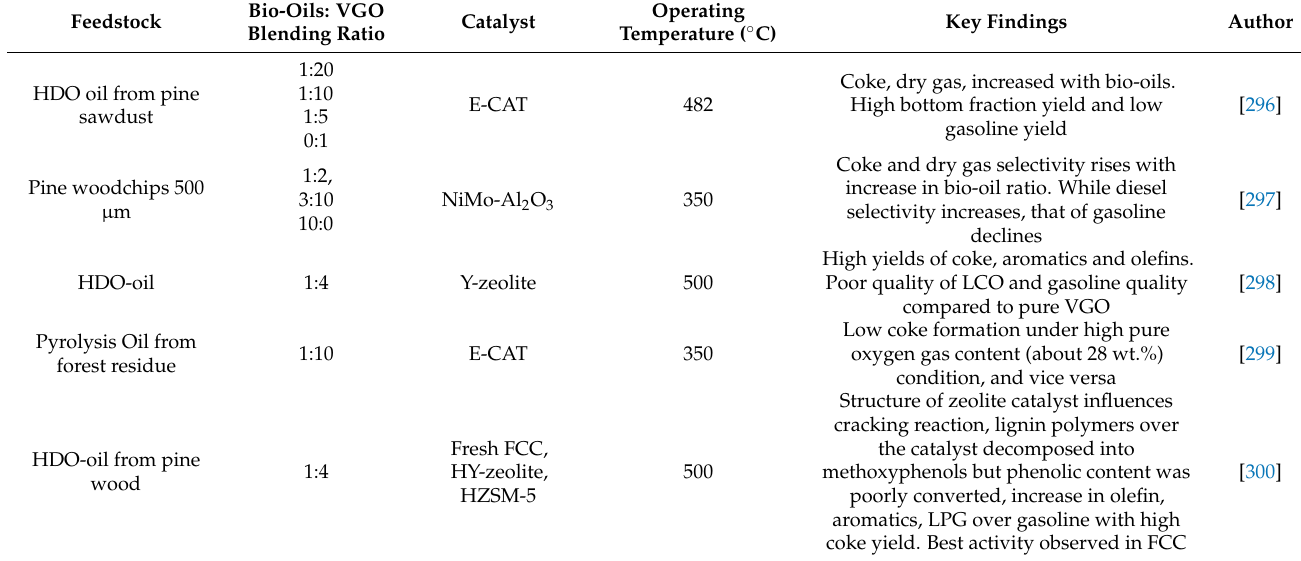
Table A1. Co-processing of biomass-based oils with petroleum oils